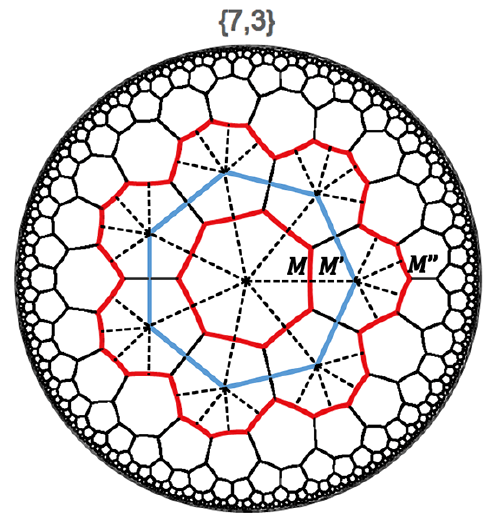
Figure 11 . The minimal polyline M , the outer adjoint polyline M 0 of polyline M and the outer adjoint polyline M 00 of polyline M 0 in the network with f 7 ; 3 g tiling (solid line) and its Poincare dual (dashed